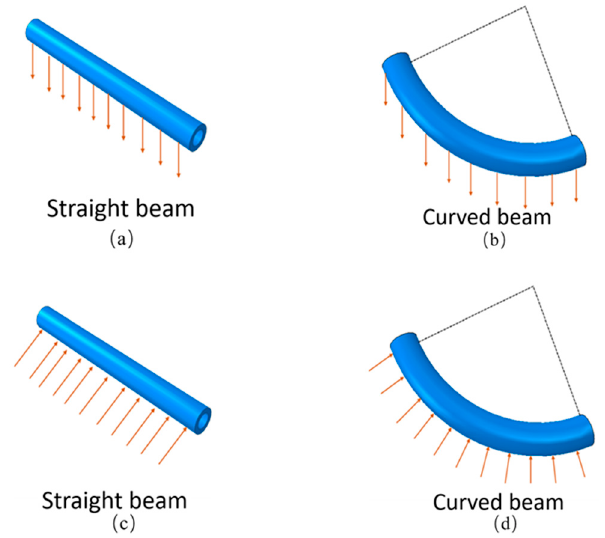
Figure 14. Demonstration of different loading directions for straight and curved beams: ( a ) the gravity load for a straight beam; ( b ) the gravity load for a curved beam; ( c ) the wind load for a straight beam; ( d ) the wind load for a curved beam.